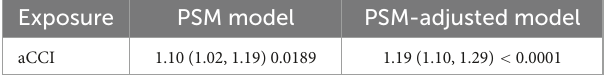
TABLE 7 Multivariate results by Cox regression under the PSM